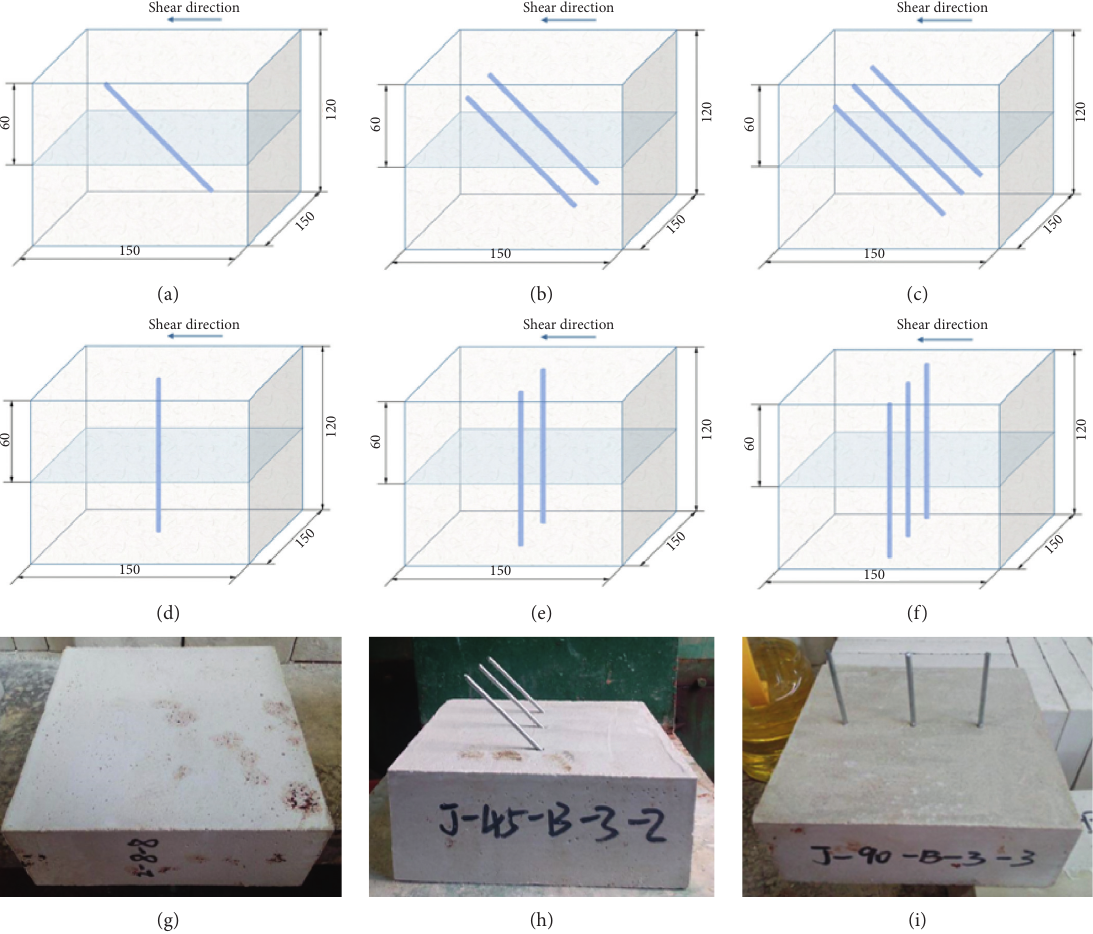
Figure 1: Schematic and products of the unbolt and bolted joint sample. (a) Joint-1-45 ° . (b) Joint-2-45 ° . (c) Joint-3-45 ° . (d) Joint-1-90 ° . (e) Joint-2-90 ° . (f) Joint-3-90 ° . (g) Unbolted joint. (h) 45 ° bolted joint. (i) 90 ° bolted joint.